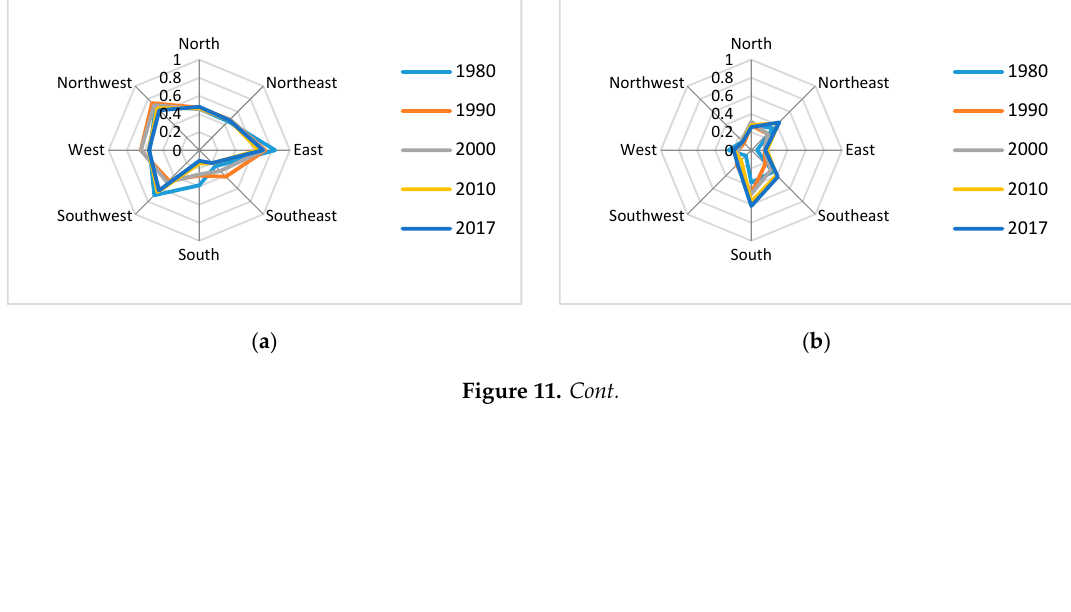
Figure 10. Hot-spot optimization analysis.